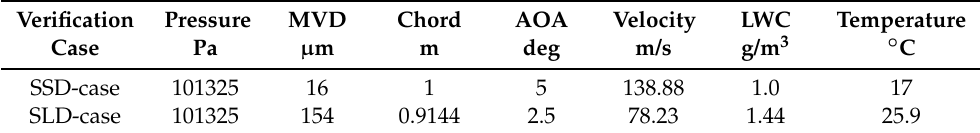
Table 1. Icing conditions for the SSD (Supercooled Small Droplet)-case and SLD (Supercooled Large Droplet)-case.